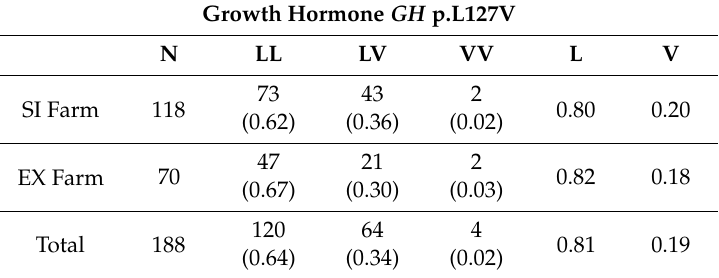
Table 1. Genotypes and alleles frequencies at the GH p.L127V in Modicana cows.